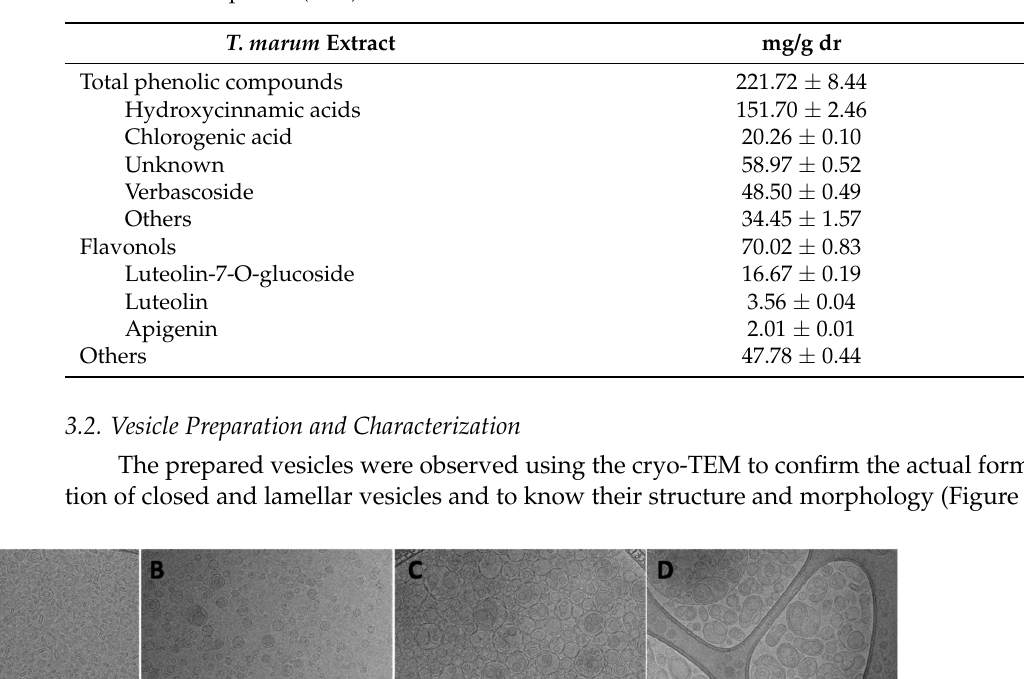
Table 2. The main components detected and quantified in the extract of T. marum obtained by ultrasound-assisted maceration in ethanol and water (70:30). The unknown phenol was quantified using the calibration curve of verbascoside, others after verbascoside using the curve of chlorogenic acid and others after apigenin using the curve of luteolin-7-O-glucoside. Mean values ± standard deviations are reported ( n =3).